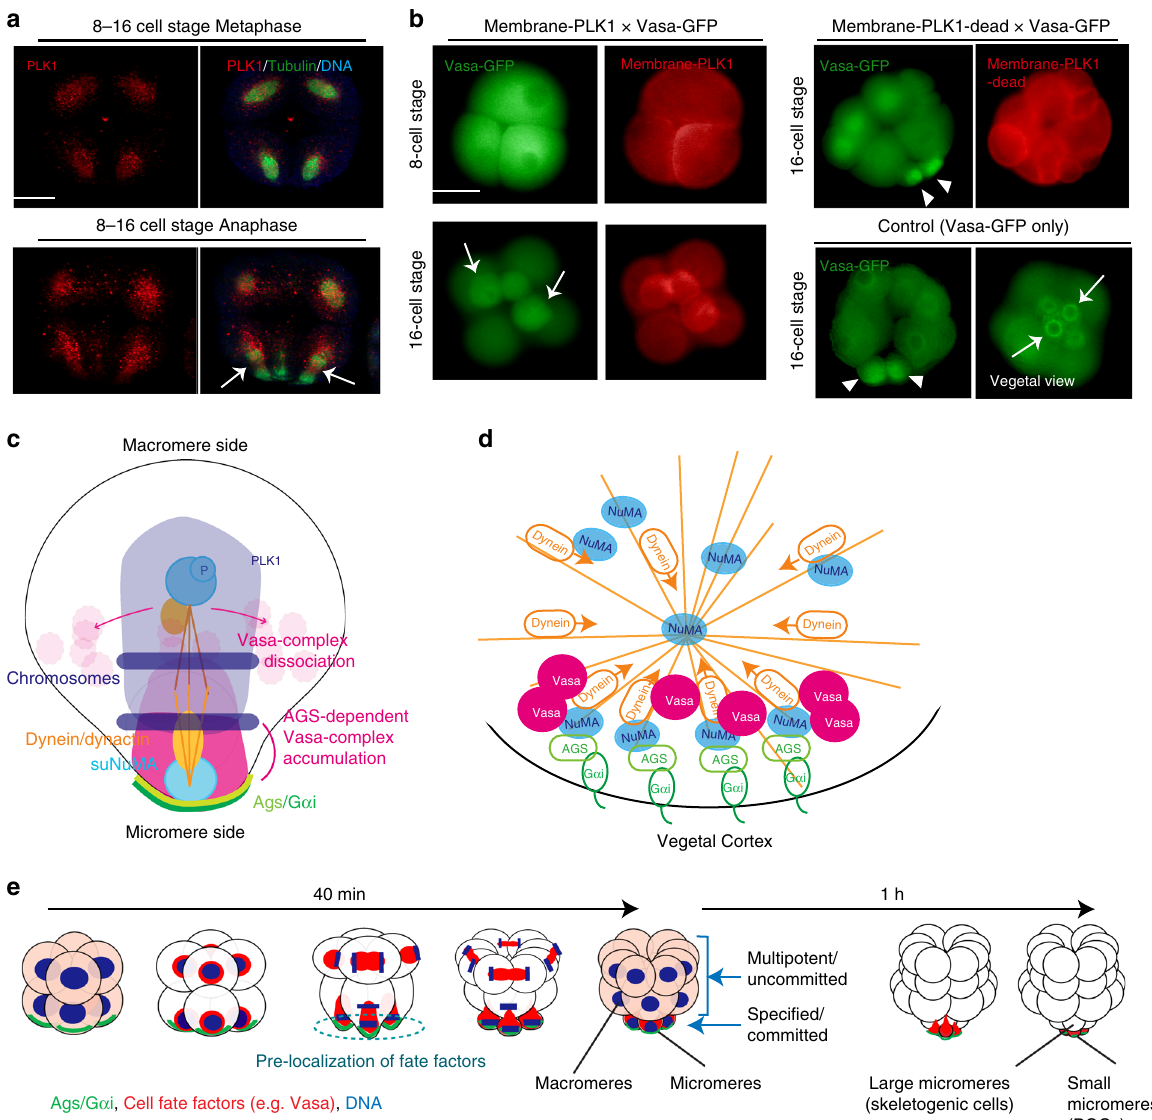
Fig. 3 PLK1 activity alters Vasa and complex localization at the vegetal cortex and a model for AGS-dependent micromere formation. a PLK1 was localized over every spindle yet was depleted from the vegetal side of the 16-cell spindle (arrows). b membrane-mCherry-PLK1 mRNA (1 μ g/ μ l stock) was co- injected with Vasa-GFP mRNA (1 μ g/ μ l stock) and images were taken in live embryos. These embryos either formed no micromeres, or resulted in the formation of aberrant size and number (1 – 3 cells) of micromere-like cells at the 16-cell stage (arrows), whereas embryos with membrane-mCherry-PLK1- Kinase-Dead (PLK1-dead) or Vasa-GFP mRNA only showed no knockdown phenotype and formed micromeres with Vasa enrichment (arrowheads). For a – b , the representative phenotypes of 85% or larger in each population are shown ( n = 100 or larger). c A working model for the molecular mechanisms of micromere formation and Vasa distribution in normal or G α i/AGS perturbed embryos. Diagram shows a vegetal tier of blastomeres at 8 – 16 cell stage that is about to form the micromeres in this embryo. The amount of AGS on the centrosomes is signi fi cantly lower at this stage and omitted from this diagram. d A hypothetical model of molecular organization at the vegetal cortex. e A summary diagram of AGS-dependent asymmetric cell divisions. AGS- dependent asymmetric localization of cell fate factors enables a rapid lineage segregation and transition to the micromere speci fi cation pathway by pre- localizing organizer factors to the vegetal cortex during asymmetric cell the GAND complex. To test this hypothesis, we induced cortical Fig. 6b, c, arrows). Further, AGS overexpressing embryos often showed more than two spindle poles (Supplementary Fig. 6d, arrowheads). With G α i overexpression, on the other hand, spindle morphology was normal and the spindles were never recruited to the cortex (Supplementary Fig. 6d, G α i-OE). Spindle made spindle morphology, cell division patterns, and morphology orientation was, however, altered, resulting in symmetric cell divisions at the 16-cell stage: spindles of the vegetal blastomeres appeared to be oriented horizontally, relative to the A-V axis, rather than vertically (Supplementary Fig. 6c, G α i-OE). There- fore, G α i might play an important role in spindle orientation.